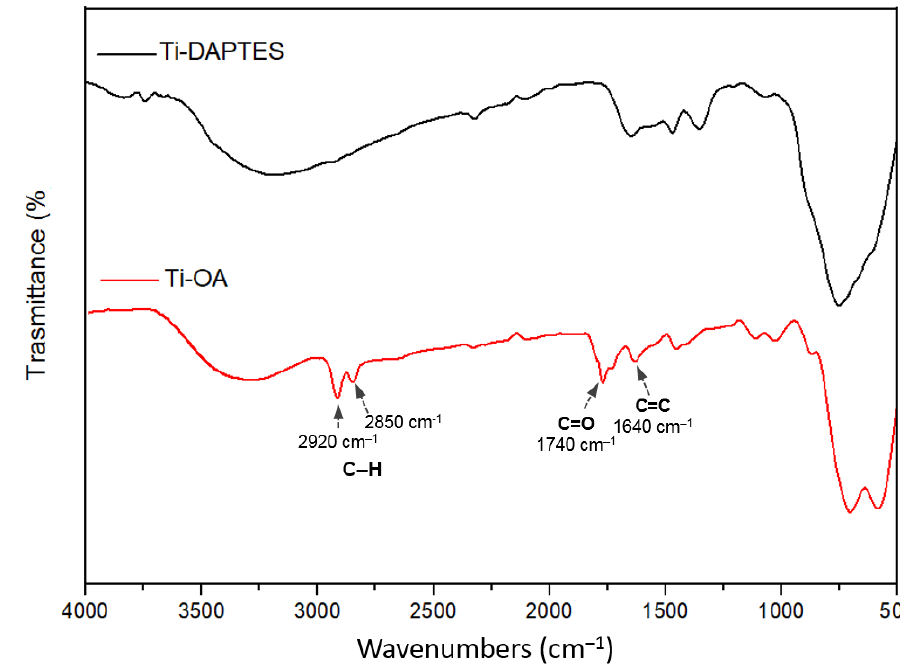
Figure 7. FTIR spectra of Ti-OH sample, compared with Ti-DAPTES.